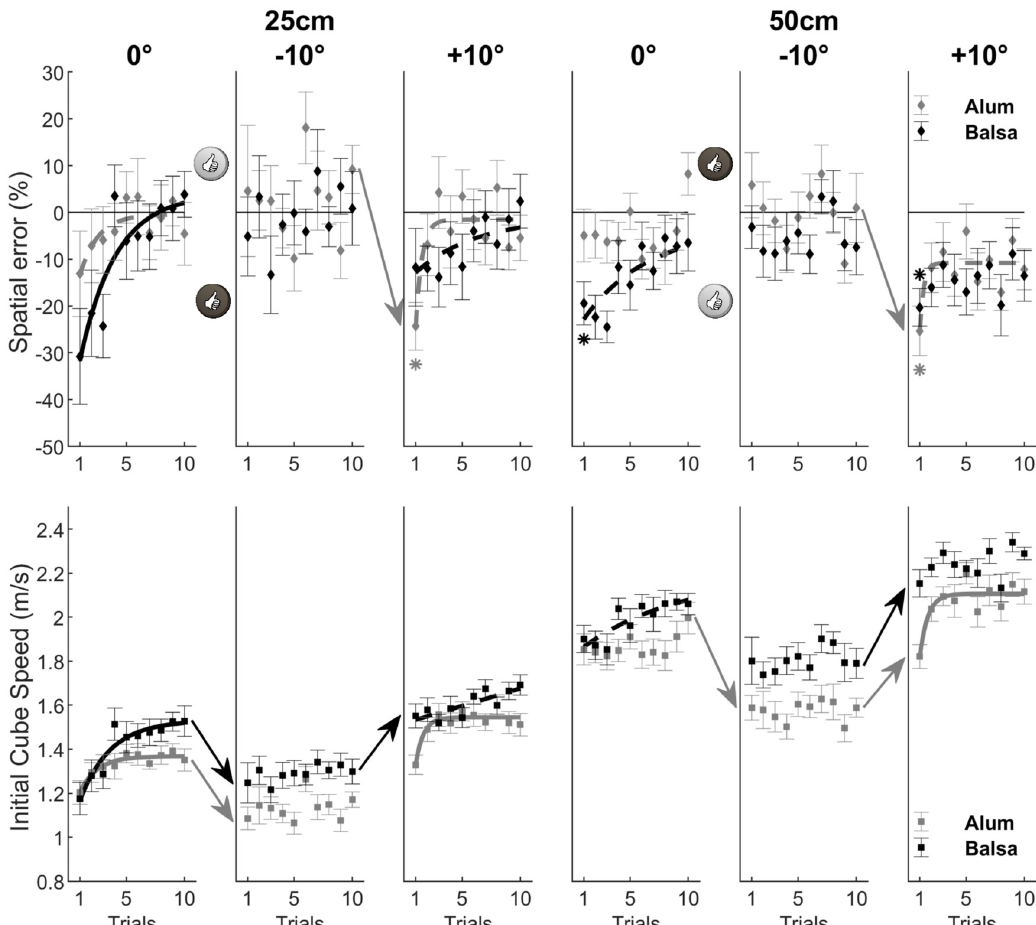
Fig 5. Performance and motor adaptation as a function of surface material, surface slope and target distance, is illustrated for the “0˚, -10˚, +10˚” block order groups. Evidence in favor of generalization of subjective μ between blocks with a given surface material is tagged with thumb-up symbols in the upper panel. This generalization occurred when the spatial error for both the last trial of a block and the first trial of the following block did not differ from zero (Bonferroni correction with α = 0.05/12); asterisks illustrate evidence against the generalization hypothesis. Exponential fits with R 2 > 0.75 (continuous lines) and R 2 > 0.50 (dashed lines) indicate strong and moderate evidence of motor adaptation, respectively. Arrows illustrate significant (Bonferroni correction with α = 0.05/4) change in behavior between blocks. The results show motor adaptation at the initial block of trials corresponding to a 0˚ slope and a 25cm target distance, whether on an aluminum or balsa wood surface depending on group (see Table 1). This calibration of subjective μ for a given surface material in the 0˚ condition led to an appropriate re-parameterization of the movement in the following -10˚ condition (see the thumb-up symbols for the 0˚ to -10˚ transitions), also illustrated in an adequate change in initial cube speed. In contrast, motor adaptation was needed for the -10˚ to +10˚ block